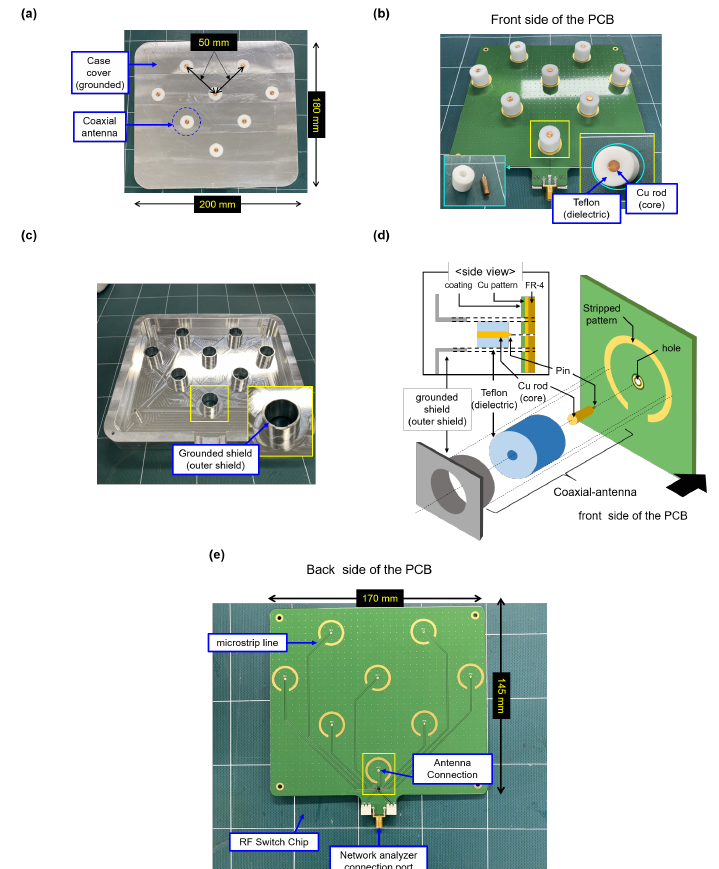
Figure 2. Photographs of ( a ) appearance of the TUSI probe, ( b ) coaxial antenna parts and the front side of the printed circuit board (PCB), and ( c ) the backside of the case cover. ( d ) Schematic diagram of the components of the coaxial antenna (the Cu rod(core), the Teflon (dielectric), and the grounded shield (outer shield)) and its installment to the PCB. ( e ) Top view of the back-side of the